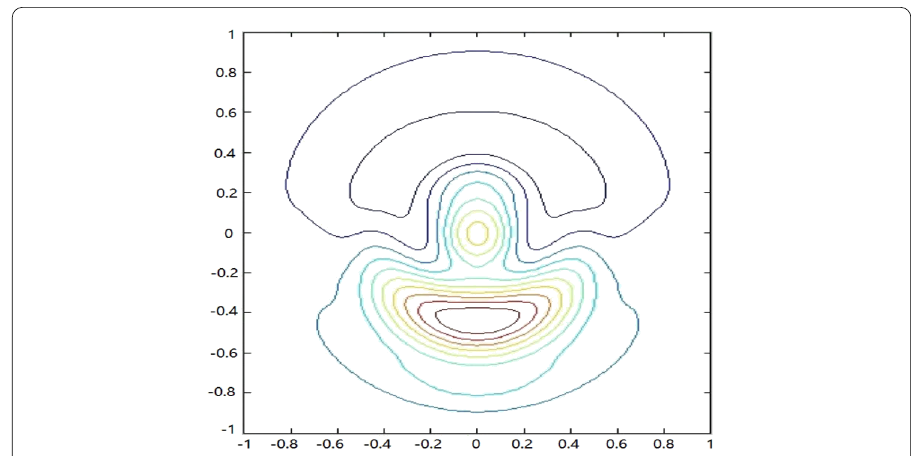
Figure 1 The ROECS solution when t = 1.0